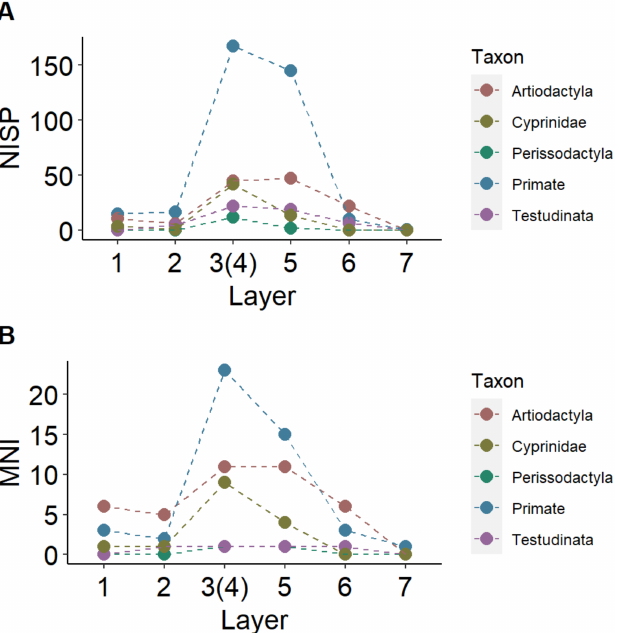
Figure 8. Diachronic change in taxonomic abundance within Area 3 N5E39: ( A ) NISP, number of identified specimens; and ( B ) MNI, minimum number of individuals.